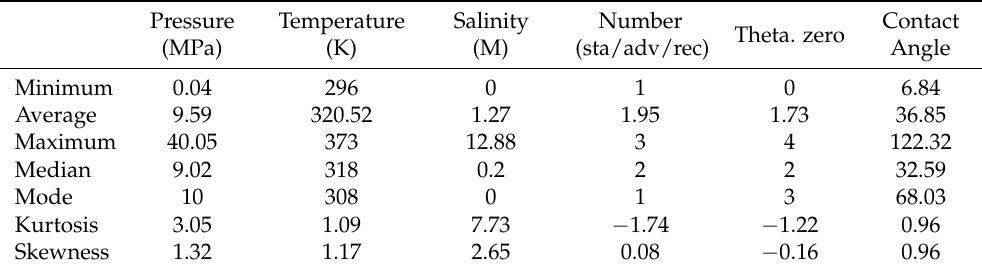
Table 1. Statistical description of the employed